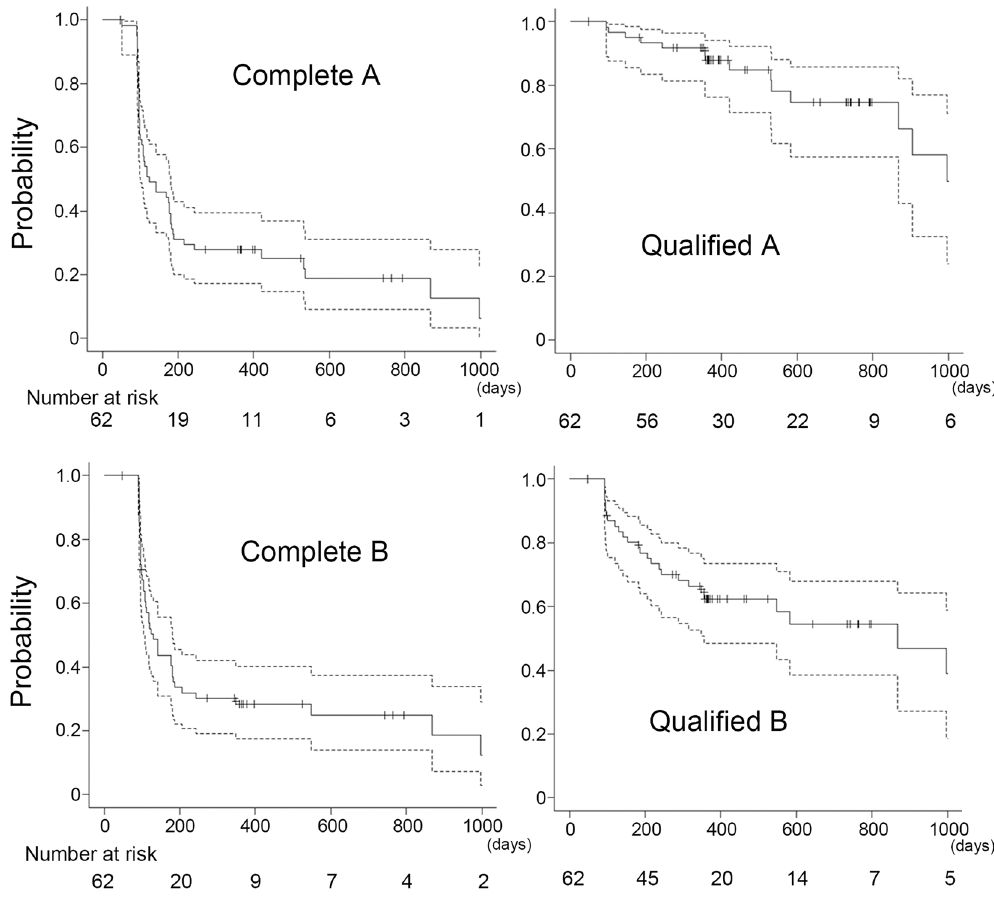
Figure 2. Kaplan ‒ Meier curve for all patients. Graphs show the curve under criterion A with (Qualified A) or without (Complete A) glaucoma medications and criterion B with (Qualified B) or without (Complete B) glaucoma medications. The dotted lines indicate the 95% confidence intervals.